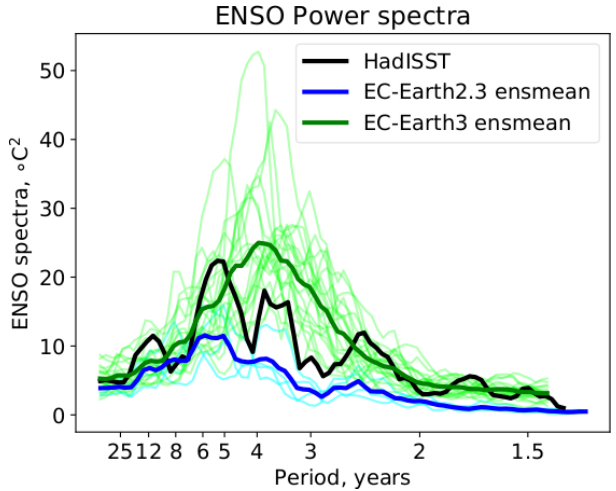
Figure 18. Power spectra of Niño3.4 sea surface temperature (SST) time series for HadISST observations (black thick line), 20 EC- Earth3 ensemble members (light green lines), and 4 EC-Earth 2.3 ensemble members (cyan lines). The EC-Earth3 and EC-Earth2.3 ensemble means are shown as green and blue thick lines, respec- tively. The Niño3.4 is calculated between latitudes 5 ◦ N–5 ◦ S and longitudes 170–120 ◦ W. The power spectra were calculated for the 1900–2009